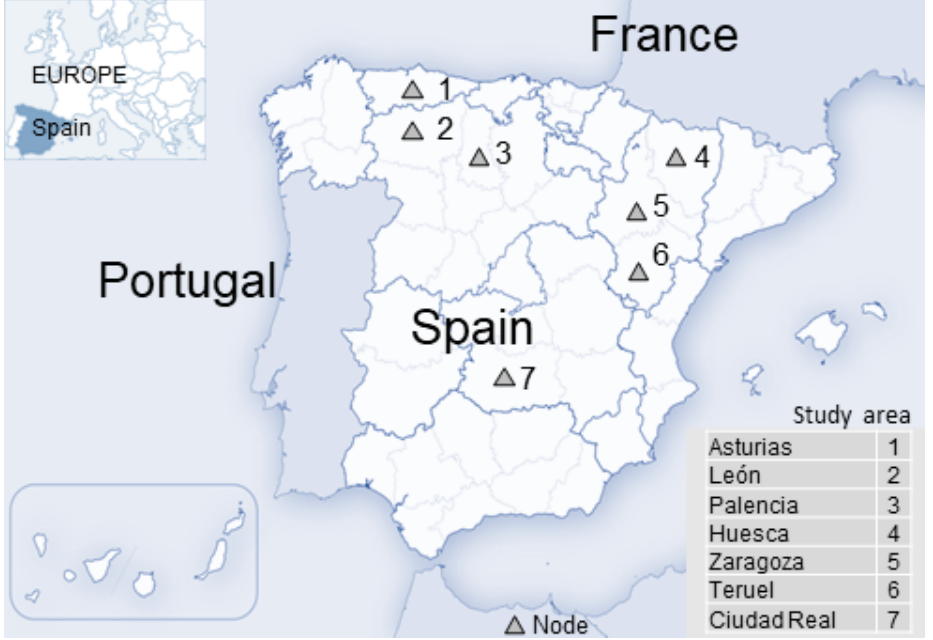
Figure 1. The study area of the coal mining regions areas of Spain.